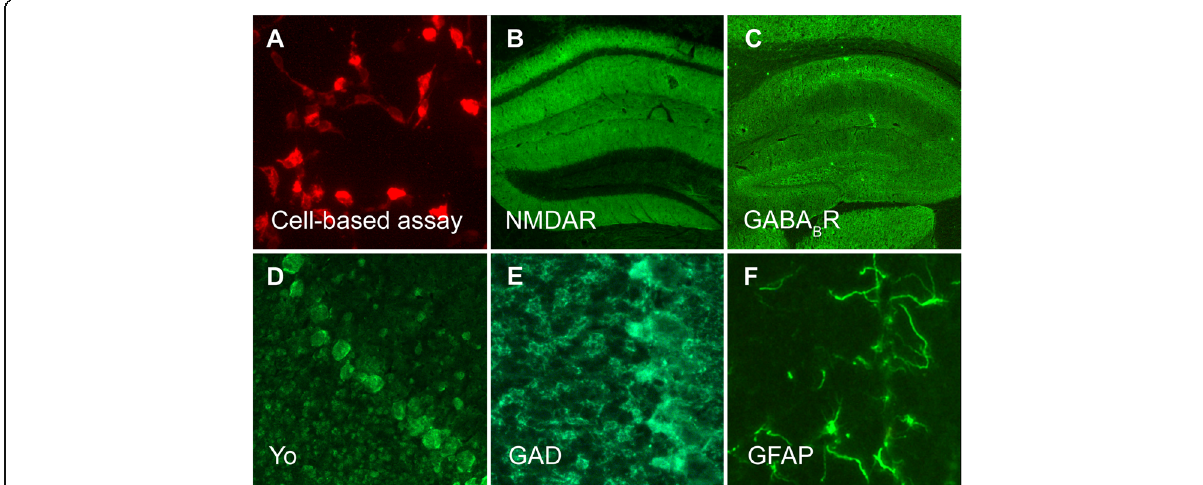
Fig. 2 Detection of anti-neuronal autoantibodies for the diagnosis of autoimmune encephalitis. a The current gold standard for established surface antibodies is the cell-based assay (CBA), in which diverse target antigens (in this example NMDAR) are recombinantly expressed on the surface of cultured cells. Binding of patient antibodies from CSF or serum samples can be visualized with fluorescent dyes. b The same CSF sample of a patient with NMDAR encephalitis shows strong binding on a mouse hippocampus section with the characteristic NMDAR distribution. c Autoantibodies to GABAbR also show strong binding to hippocampus tissue, but with a clearly distinguishable pattern. d Antibodies to onconeural antigens can be visualized by staining of line blots (not shown) or by their intracellular binding on brain sections, here Yo antibody-positive Purkinje neurons on a mouse cerebellum section. e GAD antibodies show a punctate pattern around cerebellar granule cells and Purkinje neurons. f Immunohistochemistry using brain sections also allows the detection of antibodies targeting glia cells, such as against GFAP. The methodology further permits detection of as yet undetermined anti-brain antibodies in research laboratories. D and E modified from “ Prüss et al. 2017, Neurotransmitter